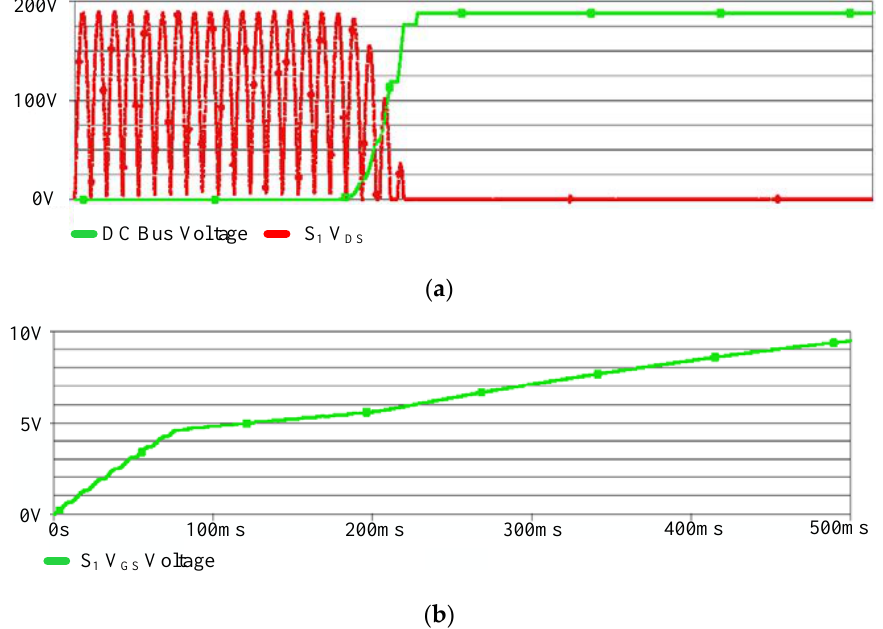
Figure 8. Indicative waveforms of the pre-charge circuit for the DC bus capacitors: ( a ) V DS voltage of the S 1 switch along with the DC bus voltage; and ( b ) V GS voltage of the S 1 switch.